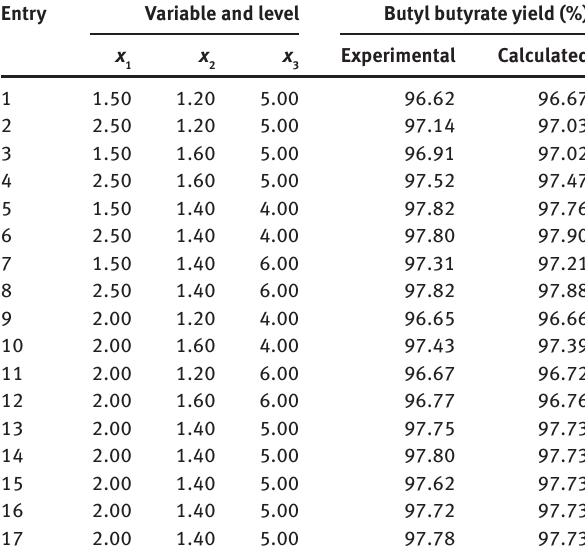
Table 3: List of experimental designs and response values during esterification of butyric acid with butanol over the H PW O [GlyH] 1.0 2.0 12 40